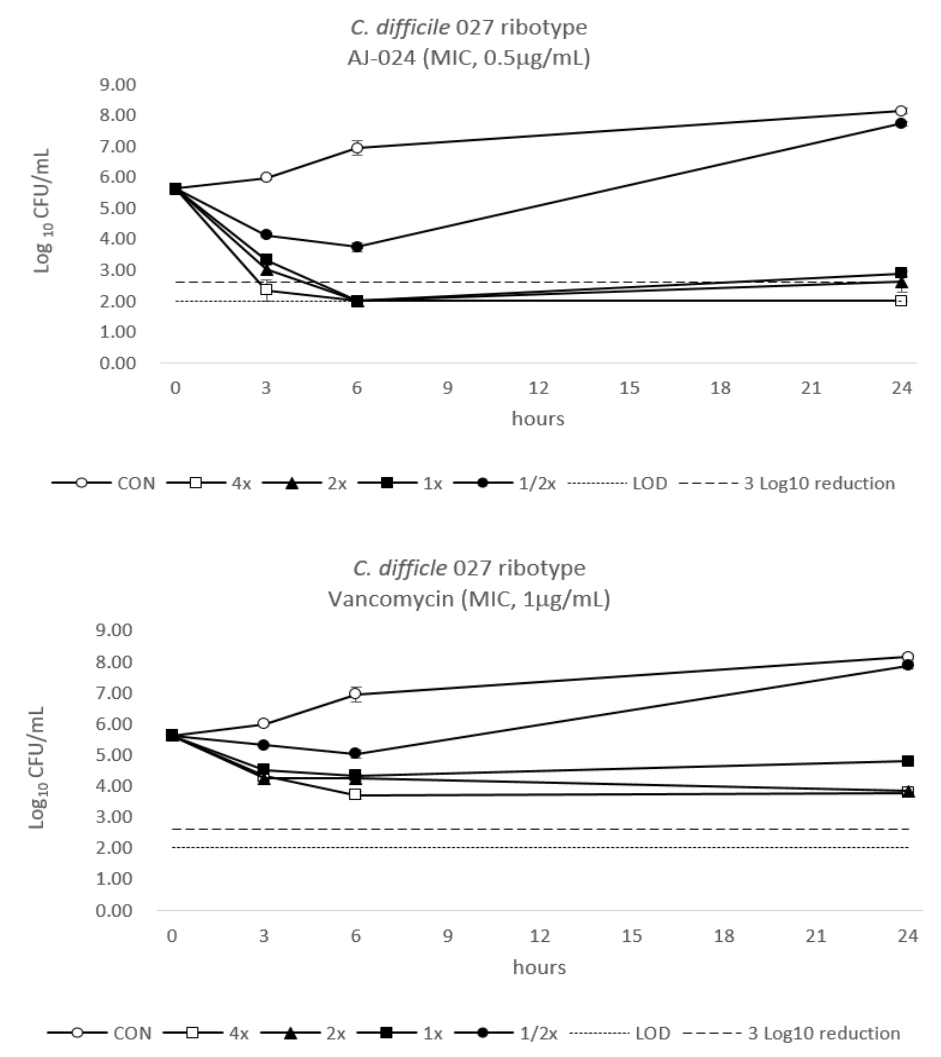
Figure 3. Twenty-four-hour time-kill curves for vancomycin (MIC, 1 µ g/mL) and AJ-024 (MIC, 0.5 µ g/mL) against C. difficile ribotype 027 .